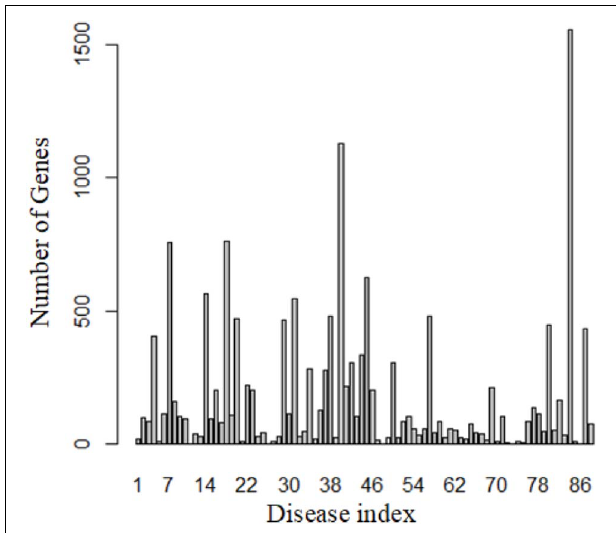
FIGURE 2 | Number of known genes for each disease.